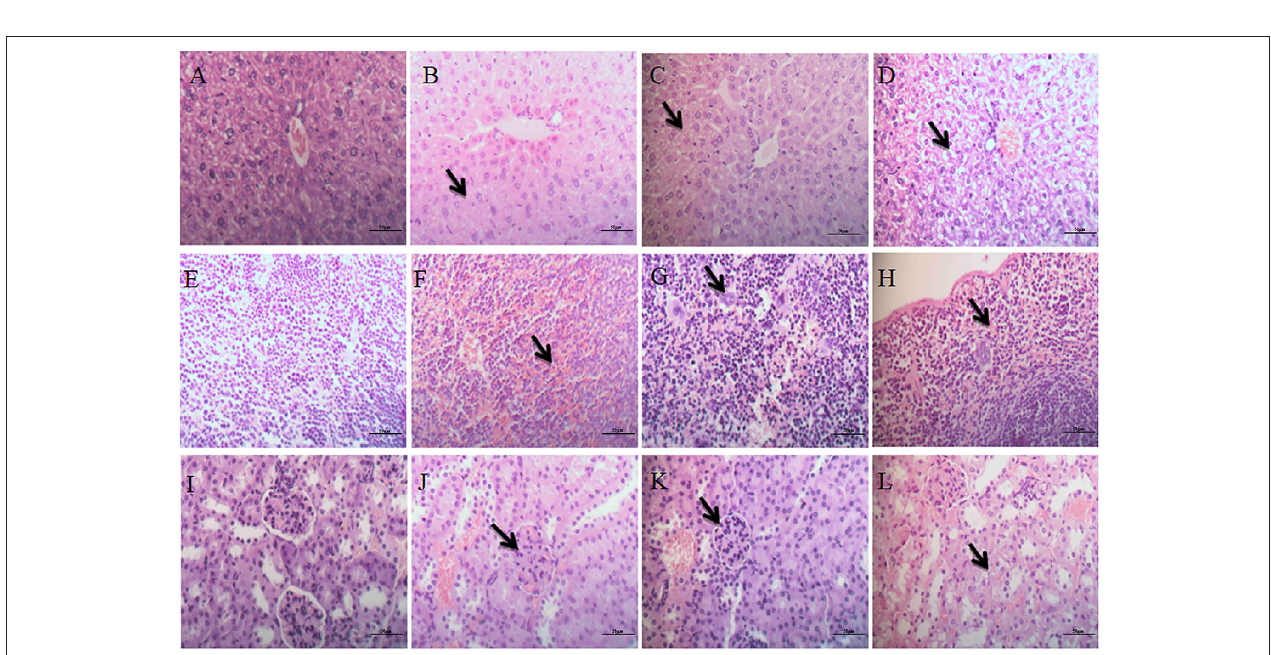
FIGURE 4 | Histopathological effects on heart and lungs. (A–D) Represent changes in the heart of control group, low-dose group, middle-dose group, high-dose group ( × 400); (E–H) represent changes in the lungs of control group, low-dose group, middle-dose group, high-dose group ( × 400). The black arrow masks swelling and necrosis and fracture of the myocardial fibers (C,D) , congestion and hemorrhage and inflammatory cell infiltration of the alveolar spaces (F–H) .